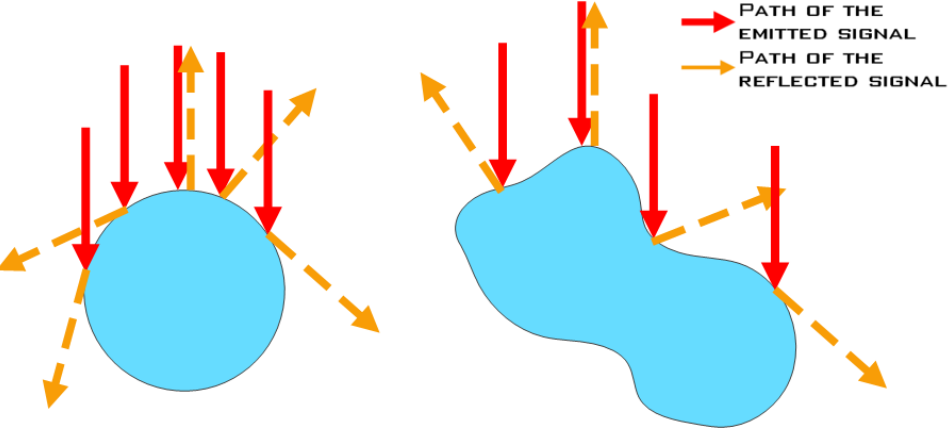
Figure 2. Specular reflections from individual bubbles of different shapes.